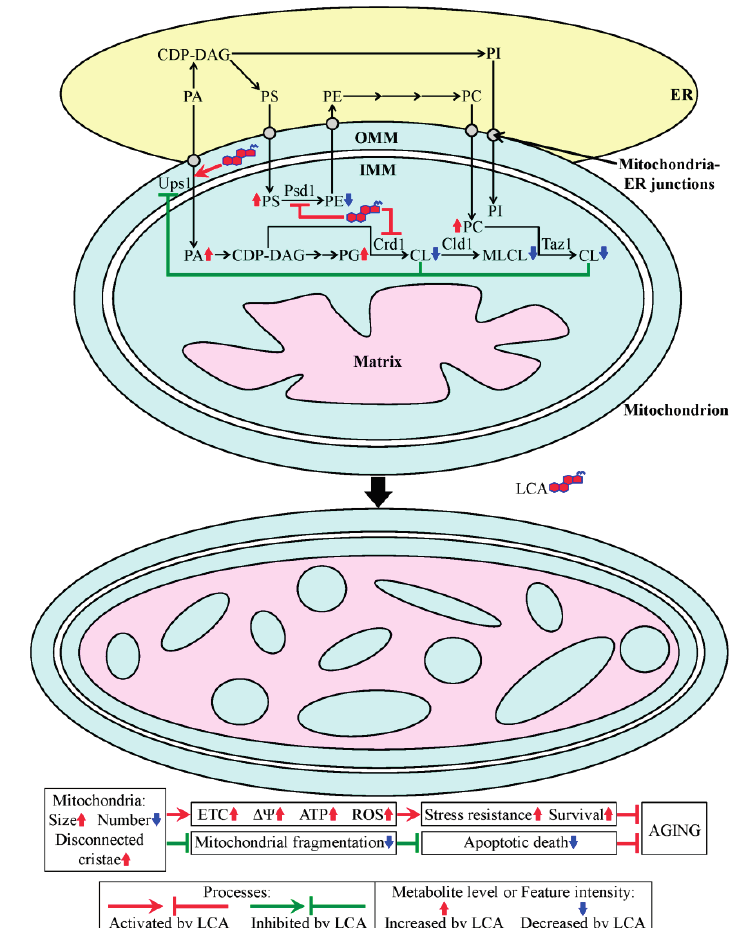
Figure 2. A mechanism through which lithocholic acid (LCA) prolongs the longevity of chronologically aging yeast. Exogenously added LCA enters a yeast cell, where it is sorted to mitochondria, but not to any other organelle. Mitochondria-associated LCA is located predominantly in the inner mitochondrial membrane (IMM) and also resides in the outer mitochondrial membrane (OMM). LCA drives a remodeling of the mitochondrial membrane lipidome, thereby enlarging mitochondria, reducing their number and causing a build-up within their matrix of cristae disconnected from the IMM. These major changes in mitochondrial abundance and morphology elevate mitochondrial respiration, membrane potential, ATP synthesis and reactive oxygen species (ROS) levels in chronologically “old” cells, thereby enhancing their long-term stress resistance and viability. Moreover, the LCA-elicited remodeling of the mitochondrial membrane lipidome mitigates mitochondrial fragmentation, thus slowing down an age-related form of apoptotic programmed cell death. All of these distinctive alterations in vital mitochondrial processes and features seen in yeast cells permanently exposed to exogenous LCA extend their chronological lifespan. See the text for additional details. Abbreviations: CDP-DAG, cytidine diphosphate-diacylglycerol; CL, cardiolipin; ER, endoplasmic reticulum; ETC, electron transport chain; MLCL, monolysocardiolipin; PA, phosphatidic acid; PC, phosphatidylcholine; PE, phosphatidylethanolamine; PG, phosphatidylglycerol; PI, phosphatidylinositol; PS, phosphatidylserine; ΔΨ , electrochemical membrane